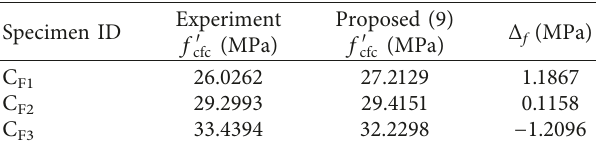
Table 5: Comparison of peak stresses between the proposed and experimental results.